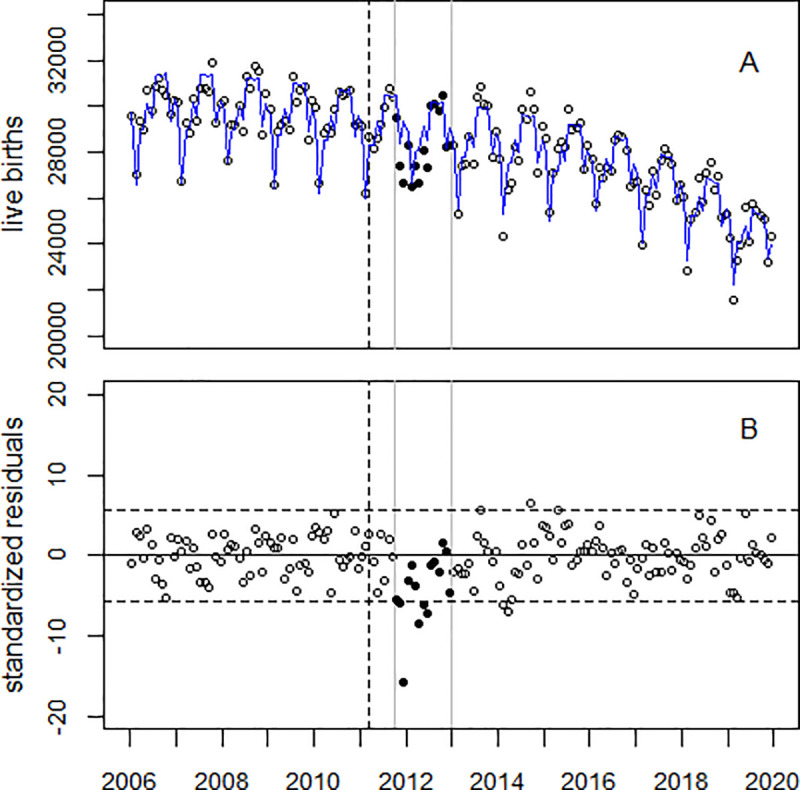
Panel A: Monthly numbers of LB in the study region, 2006–2019, and trend line. Panel B: Deviations of the observed numbers from the expected trend in units of standard deviations (standardized residuals). The black circles show the data in the time window (Oct 2011 through Dec 2012); the broken vertical line denotes March 2011.